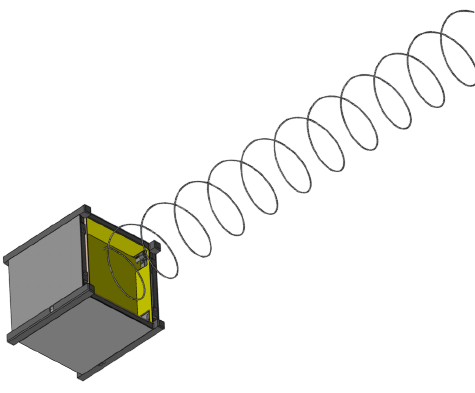
Figure 10. Model with cubic cup ground plane and CubeSat